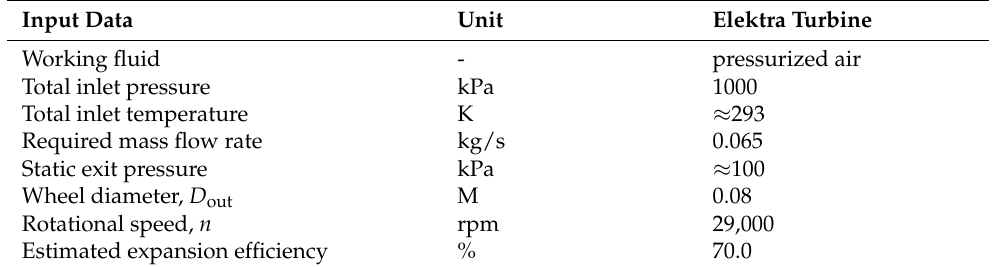
Table 1. Input data for the 1DTDT with corresponding values for the Elektra